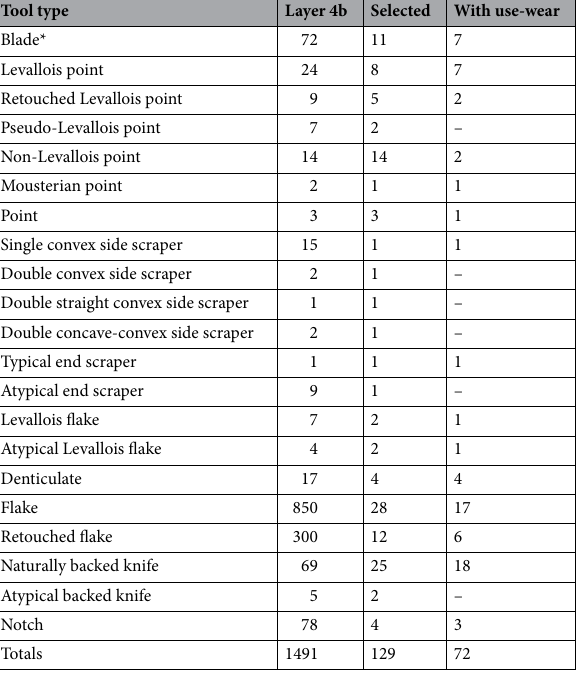
Table 1. Main artifact categories from NMO layer 4b that were screened as part of the functional study, along with the number of artifacts selected in the final sample and the number of artifacts that showed use-wear. *Blade category includes unretouched and retouched